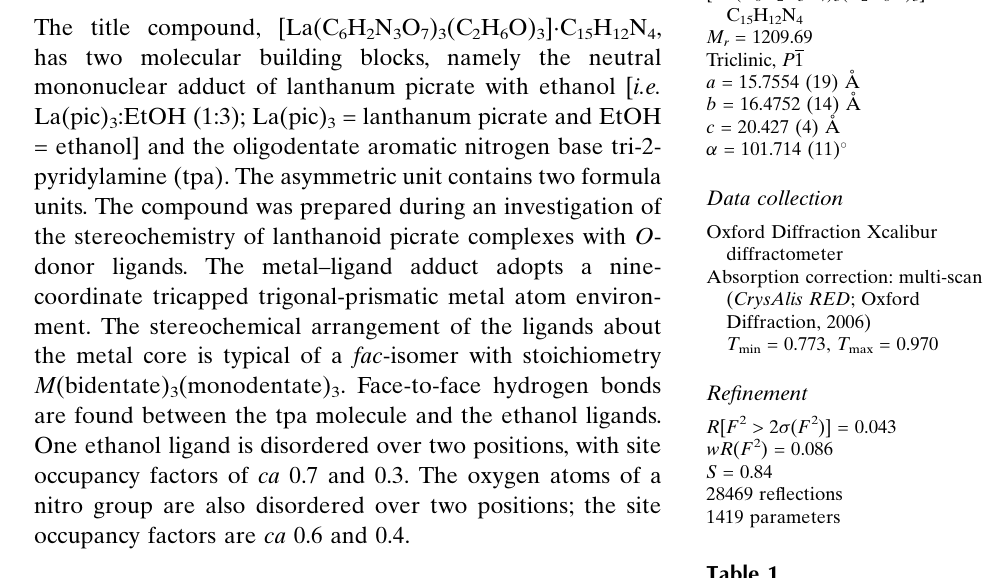
Hydrogen-bond geometry (A ˚ , (cid:2)